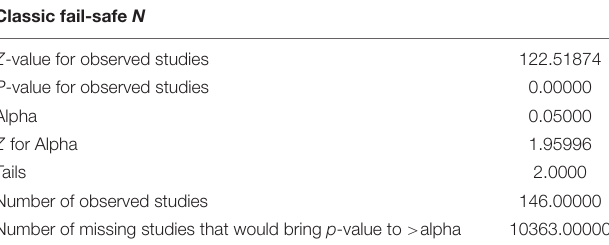
TABLE 3 | Publication bias